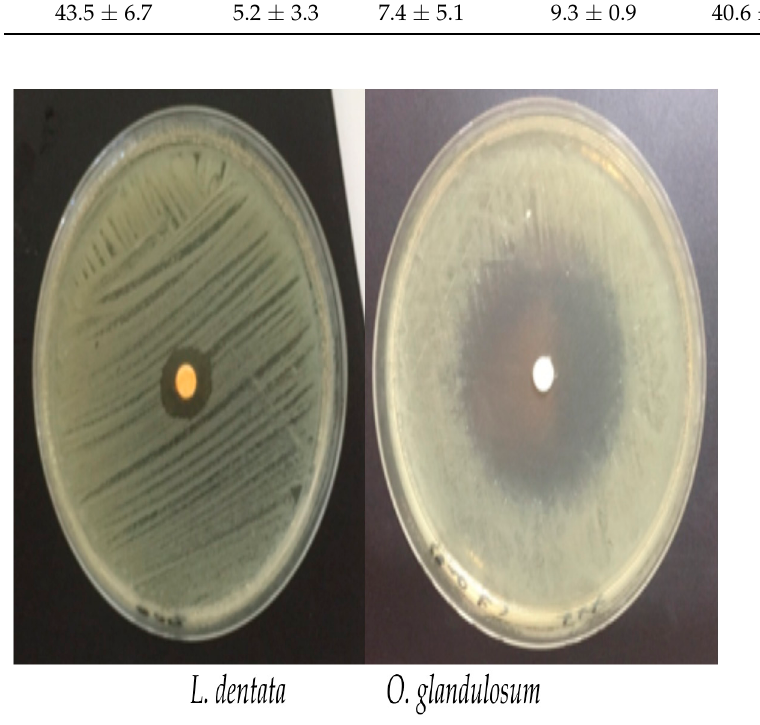
Figure 1. Inhibition halo of the L. dentata and O. glandulosum on activity against specific ESBL K. pneumoniae strains, by disc diffusion method observed at the MIC values.